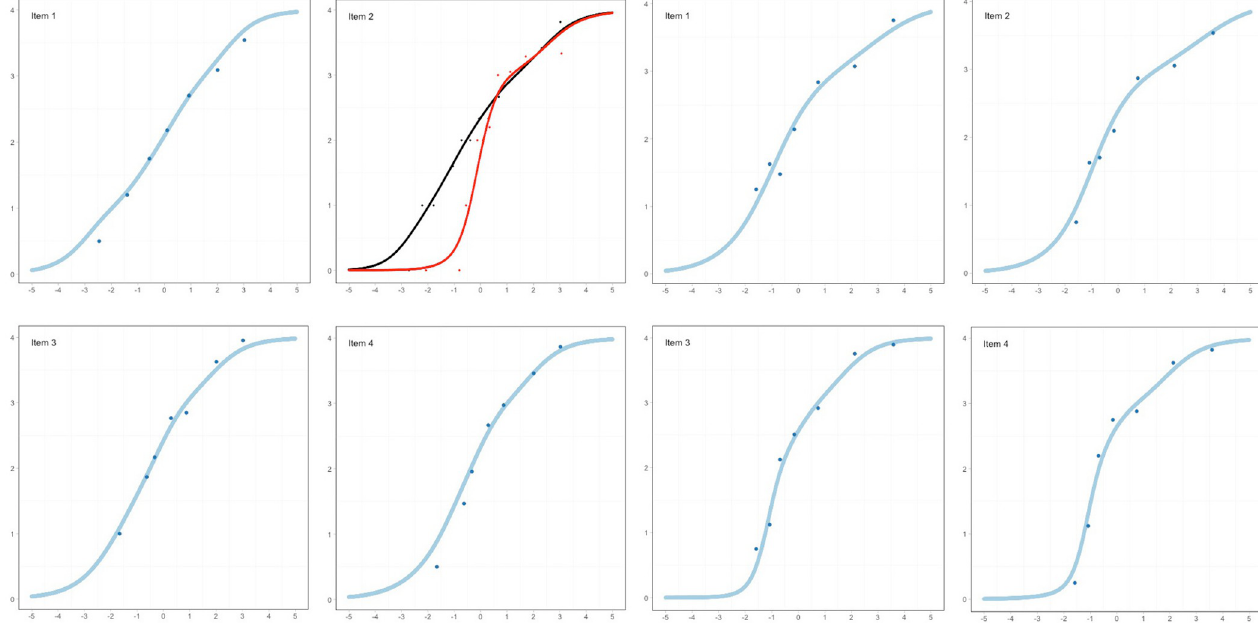
Fig 2. Item characteristic curves of the GLLRM for sample 1 (left) and sample 2 (right). Note. The x-axis indicates the latent trait (“Social support”) and the y- axis indicates the item score. The points represent the average observed item responses in each of the seven class intervals. Since Item 2 had DIF by employment status, the Item Characteristic Curves (ICCs) for participants employed (black) and not employed (red) are displayed.